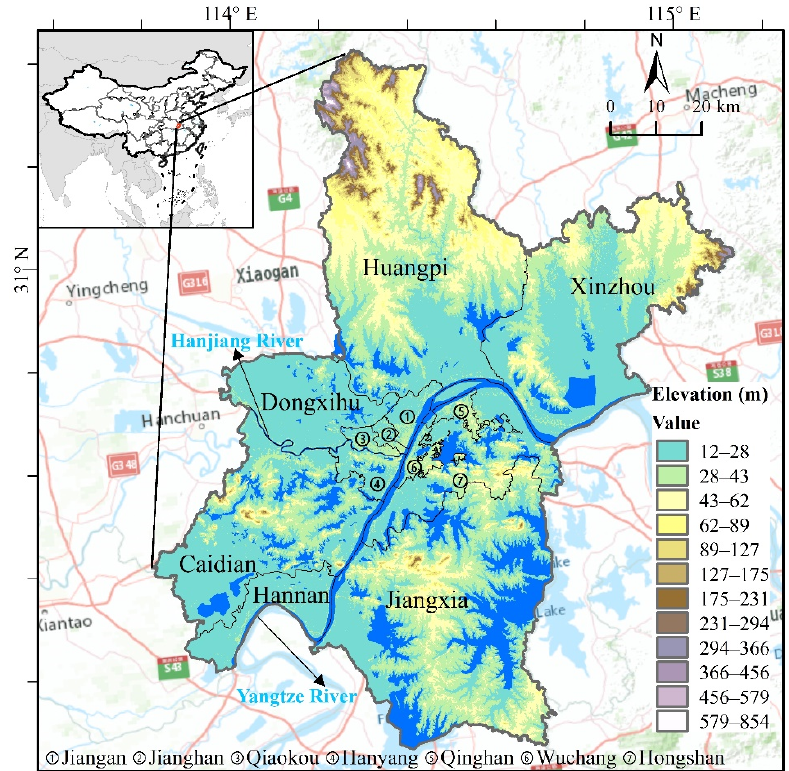
Figure 1. Location of Wuhan